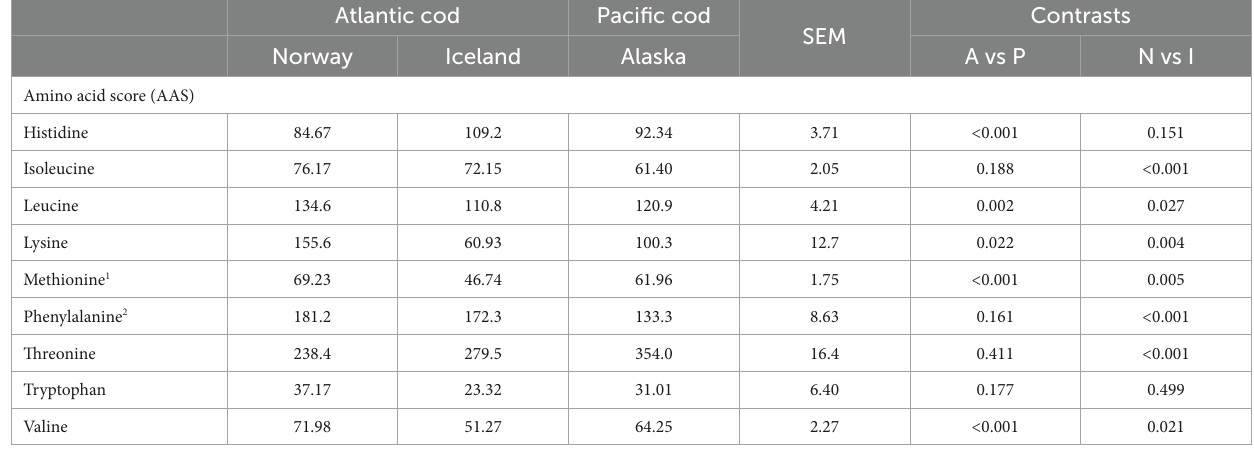
TABLE 3 The amino acid score (AAS) for all the indispensable amino acids (mean ± standard deviation).